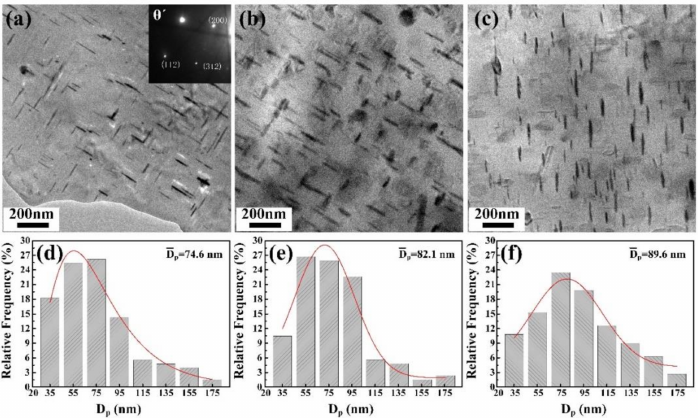
Figure 6. Precipitates of Al-Si 13 -Cu 0.5 -Ni 2 alloys after different hours of aging: ( a ) 6 h, ( b ) 10 h, and ( c ) 14 h. ( d – f ) The precipitates size distribution of these